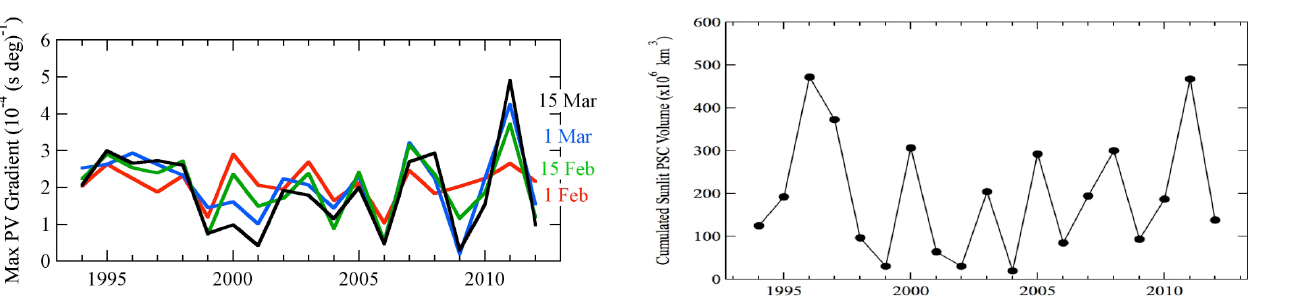
Figure 11. Cumulated sunlit VPSC between 400-675 K since 1994. The PSC volume in 2011 was of same order of magnitude to that of 1996.